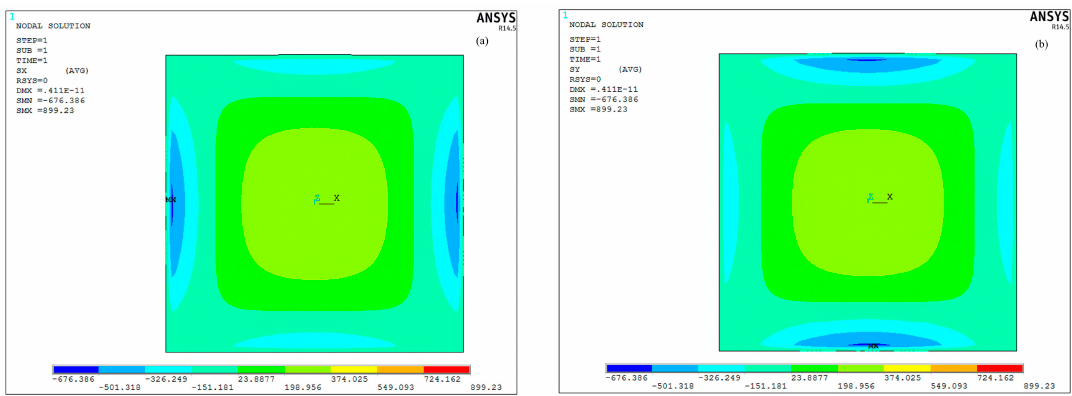
Figure 5. The stress distributions of the piezoelectric composite diaphragm in ( a ) the X and ( b ) the Y direction.